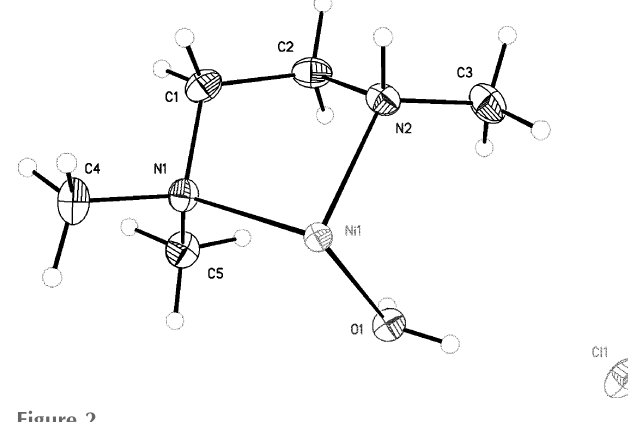
Figure 2 The molecular structure of the asymmetric